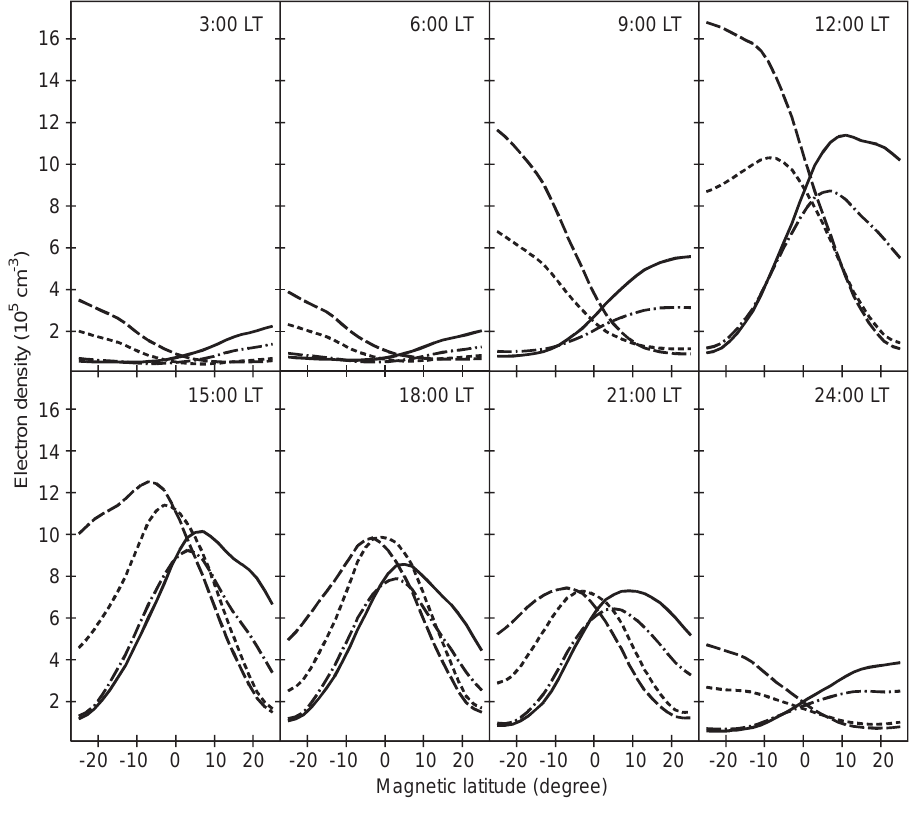
Fig. 4. Latitudinal variations of the modelled electron density, at inter- vals of 3 h, for both the HWM90 neutral wind model (June solstice, solid curves ; December solstice, long-dashed curves ) and the revised neutral wind model (June solstice, dot long-dashed curves ; December solstice, short-dashed curves )